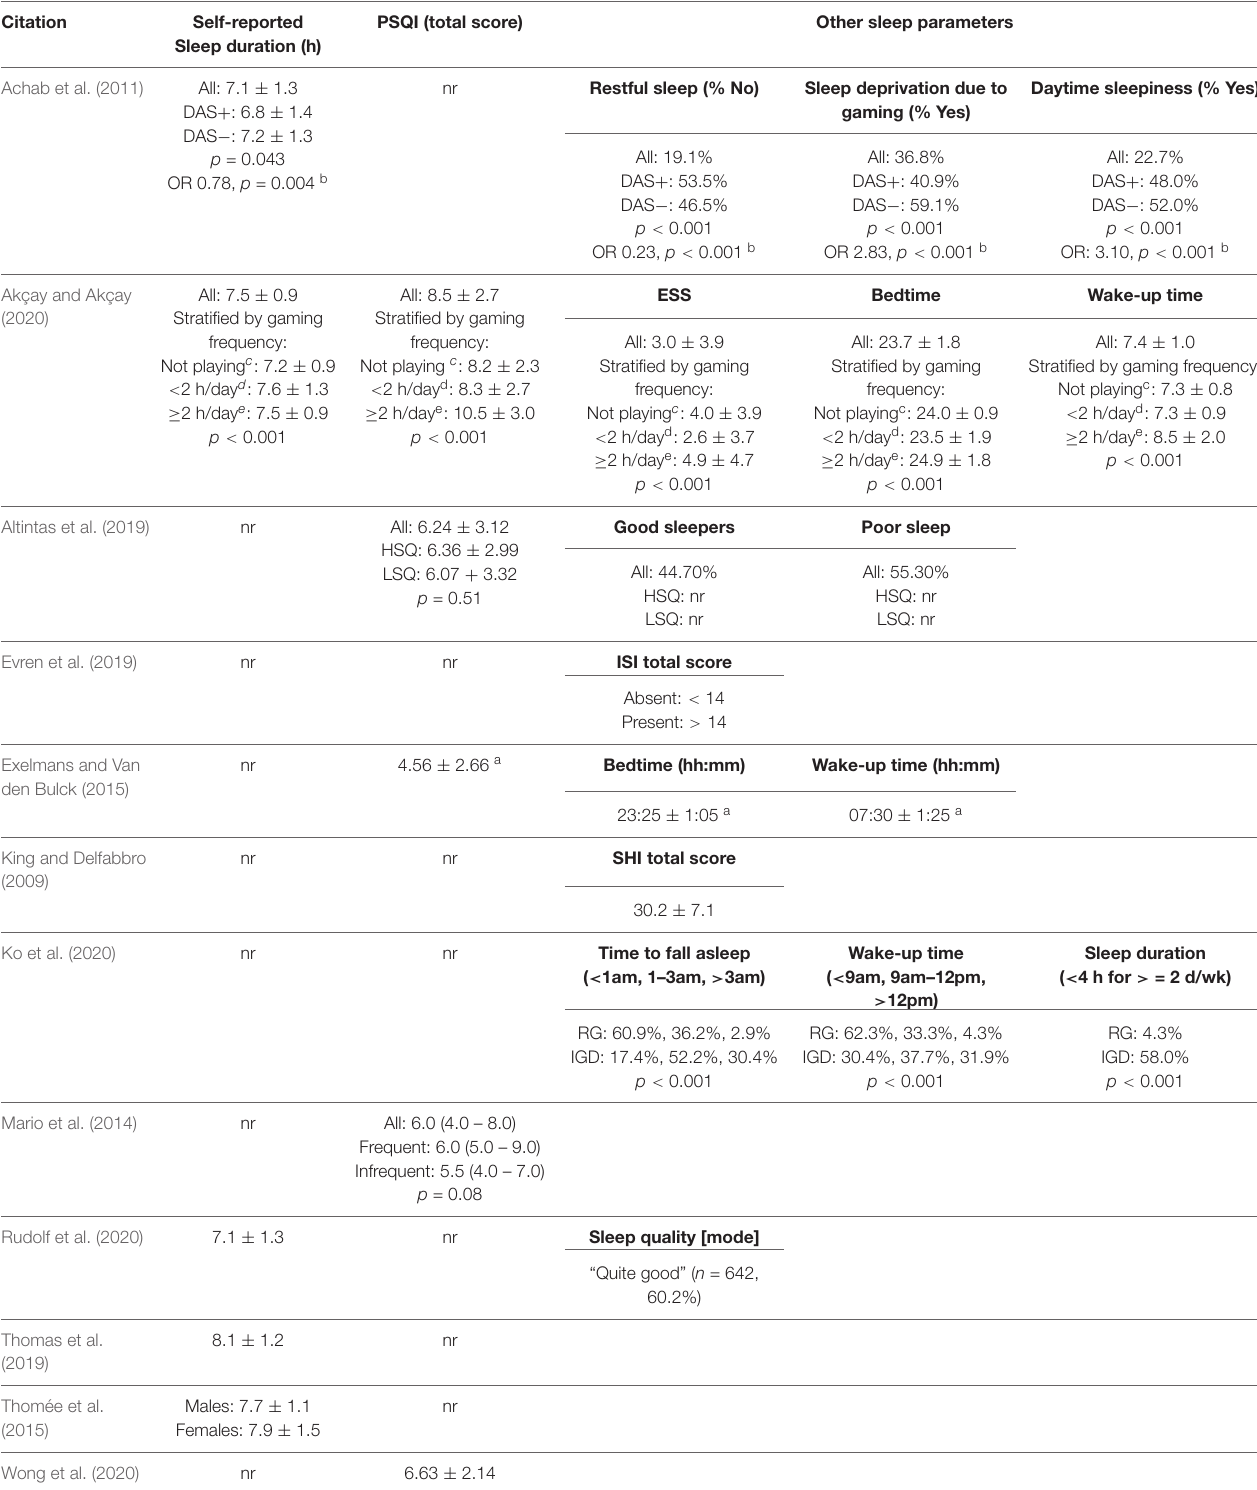
TABLE 3 | Sleep characteristics reported by the included